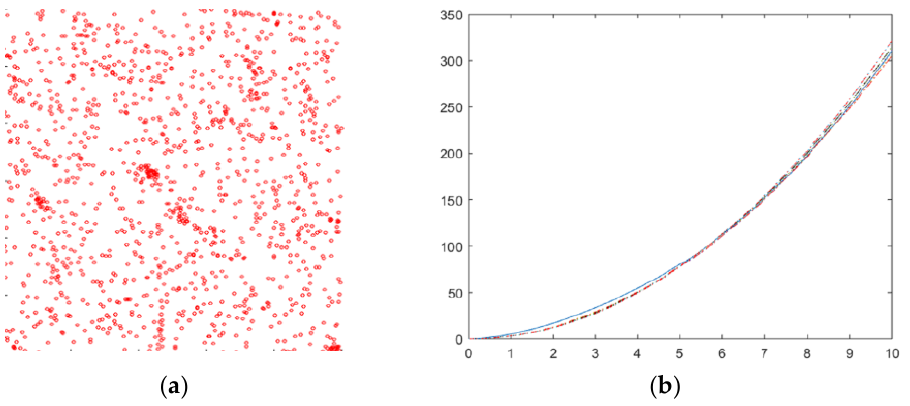
Figure 5. ( a ) Poisson random point process; and ( b ) Ripley ’s K-function. This plot is given in Figure 5b, where we see possible evidence for clustering, because the observed K-function is above the curve corresponding to a random process (theoretical one); where blue is the observed K-function, black dashed is the theoretical K-function, and red dashed are the lower and upper limits for K-Function. Especially at small scales ( d < 5), the process does not show evidence of clustering. At other scales ( d >5), we have evidence of clustering. The lower and upper limits for the K-functions are given by ( ) ( ) min L d K d = and ( ) ( ) max U d K d = . Another approach, based on the K-function, is to transform using ( ) ( )/ L d K d = ddK )( or dL == )( , where peaks of positive values in a plot would correspond to clustering for the corresponding scale d [19 – 22]. Figure 6b represents the graph between the L-function and the theoretical one, and clearly shows evidence of regularity, as well as the Poisson random point process with 1000 positions (Figure 6a) [28 – 30]. ( a ) ( b ) Figure 6. ( a ) Poisson random point process; and ( b ) L-function. In the L-function graph, the clustering is better illustrated, with a blue line (observed L-function) above the black dashed line corresponding the theoretical one; red dashed lines are the lower and upper limits for L-Function with ( ) ( ) min L d L d = and ( ) ( ) max U d L d = . Since the L-function lies above the upper limit, the clustering is sig- nificant.